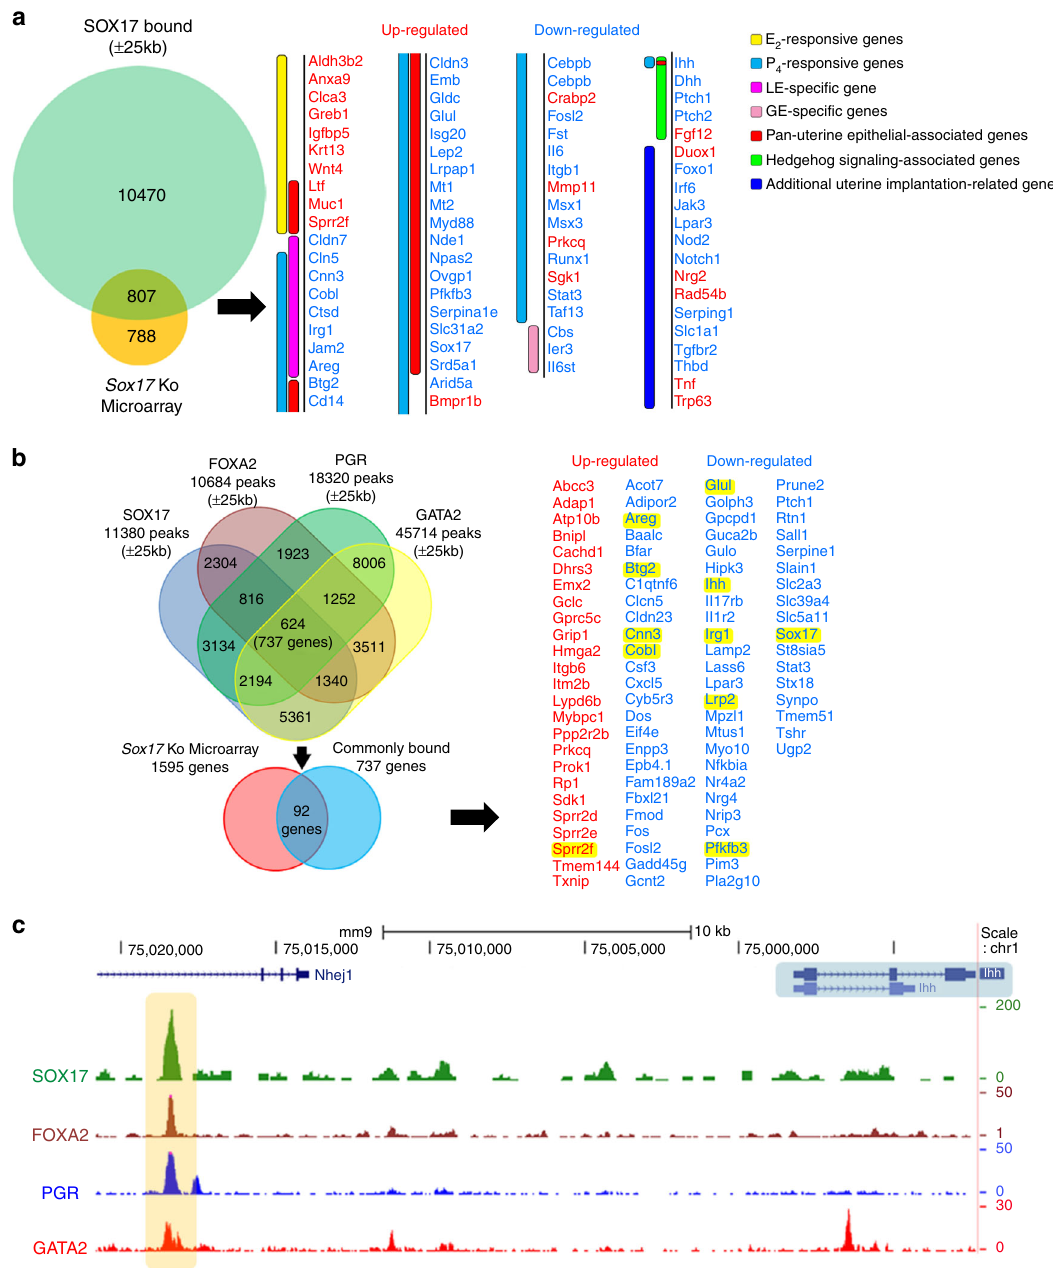
Fig. 6 Binding and regulation of Ihh by analysis of SOX17 uterine cistrome. a SOX17 ChIP-seq using Sox17 f/f mice identi fi ed to 11277 genes with binding intervals within 25 kb of the gene boundary. Of these genes, 807 were differentially regulated in the Sox17 KO microarray at GD 3.5, and 78 genes were directly associated with uterine receptivity and implantation. b Analyses of SOX17, FOXA2, PGR, and GATA2 ChIP-seq data sets identi fi ed 624 common peaks, which assigned to 737 genes. Of these genes, 92 genes were identi fi ed as SOX17 target genes with shared binding sites by FOXA2, PGR, and GATA2. c Genome browser tracks of SOX17, FOXA2, PGR, and GATA2 binding at putative enhancers for Ihh gene in P 4 -treated or GD 3.5 uteri. UCSC Genome Browser views showing the mapped read coverage of SOX17, FOXA2, PGR, and GATA2 ChIP-seq data. The Ihh gene locus and the regions targeted by gRNAs for CRISPR/Cas9 deletion in vivo are highlighted in blue and yellow, respectively. Ihh19, putative enhancer 19 kb upstream of Ihh gene